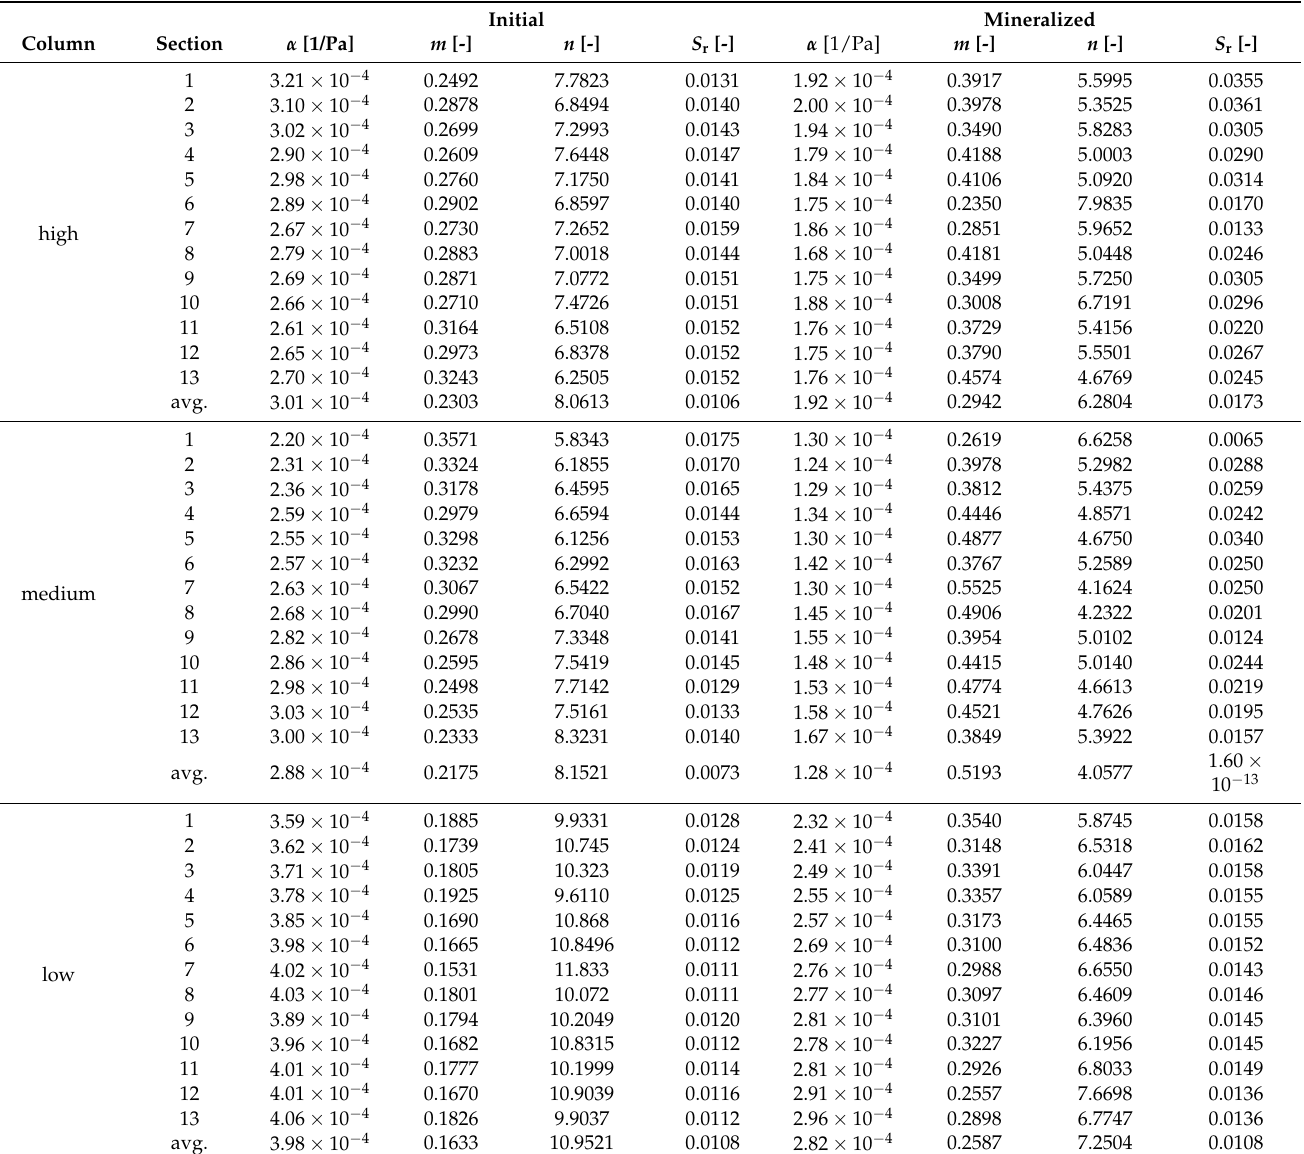
Table 6. Parameters of the Van Genuchten capillary pressure–saturation relation (Equation (5)) for the initial and mineralized 3D